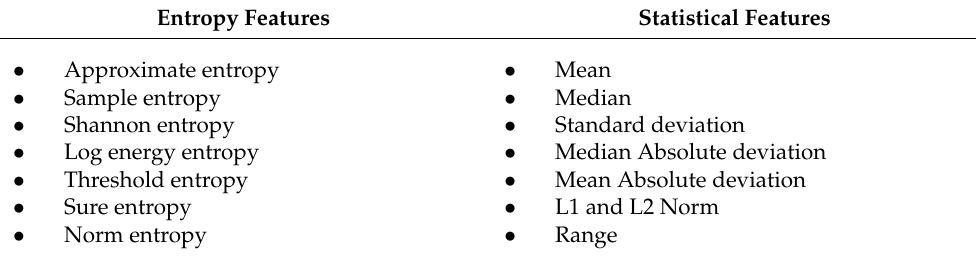
Table 1. Proposed feature